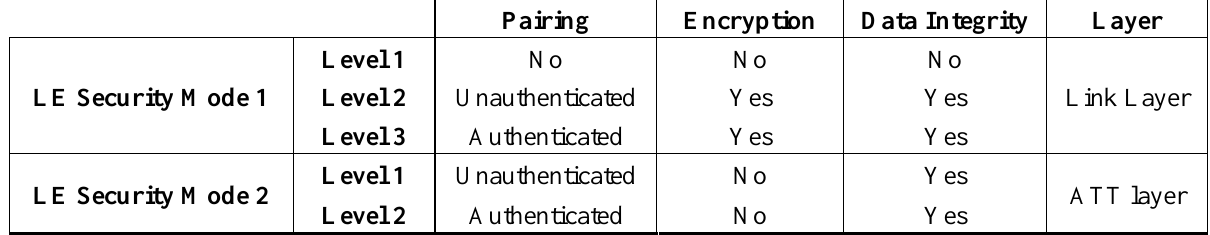
Table 1. Security services and features for the security modes and levels defined in